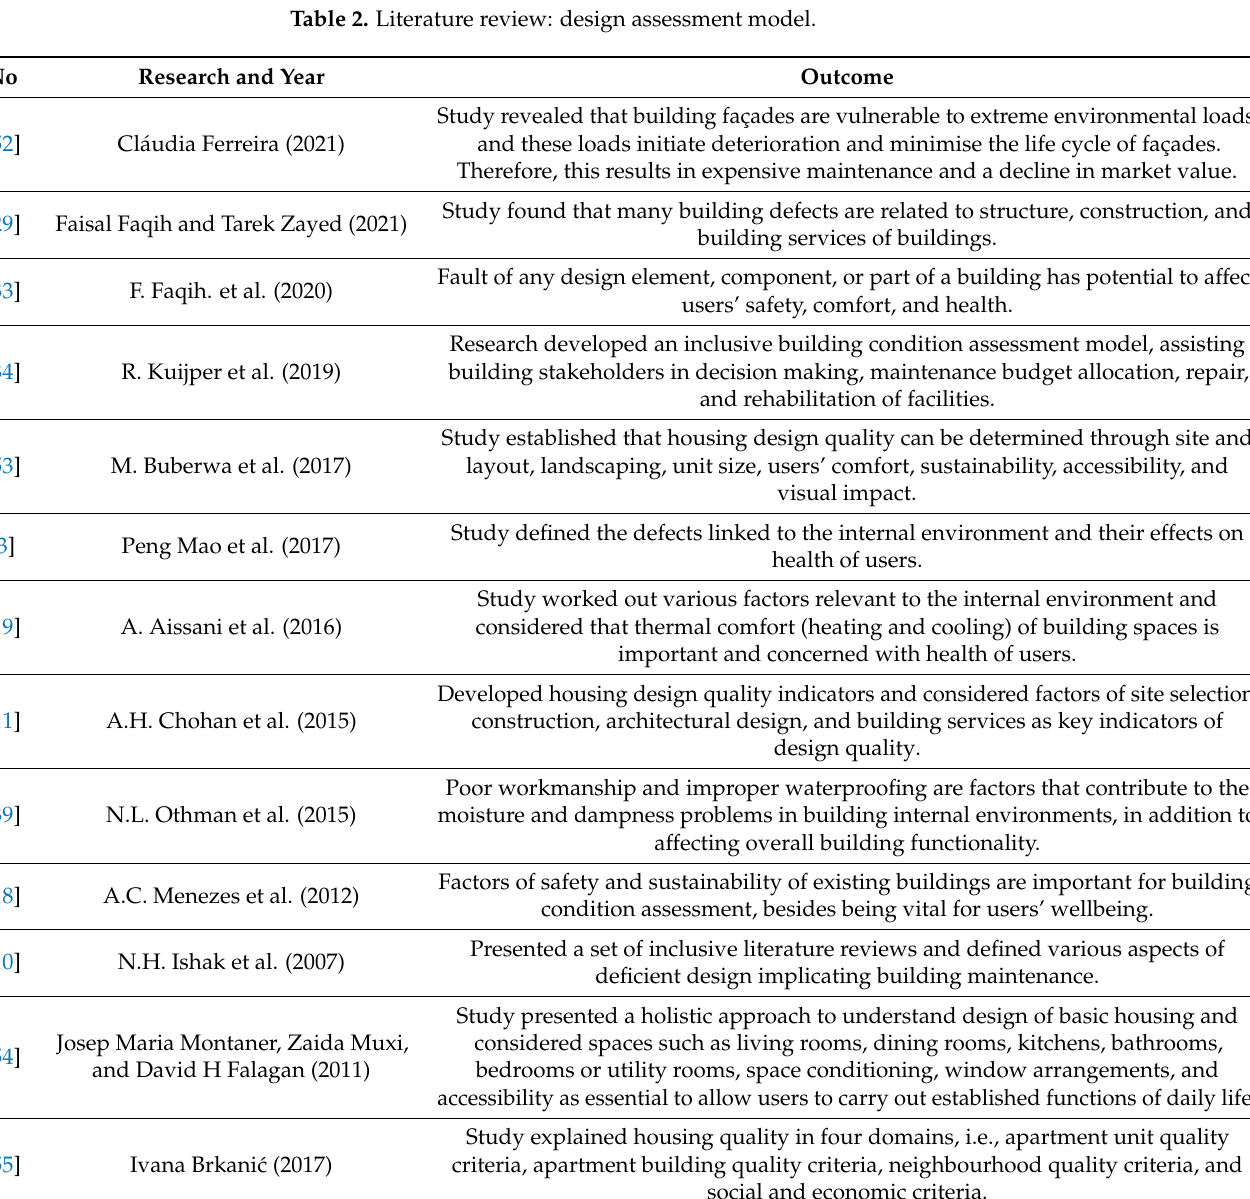
Table 2. Literature review: design assessment